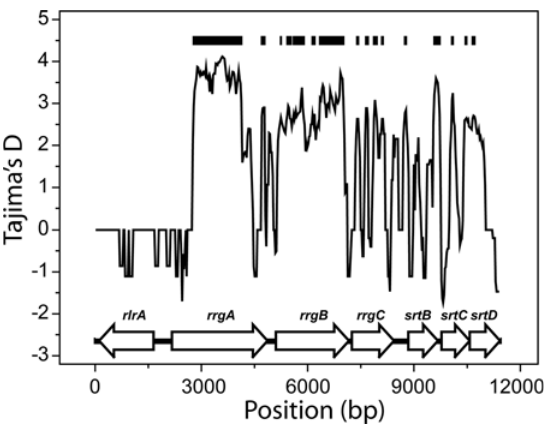
Dark lines mark the regions where the value of D is positive with p- value , 0.001. Also shown are the positions of the ORFs along the sequence. Most of the regions with significantly positive values of D are located in the regions encoding for the RrgA and RrgB proteins.